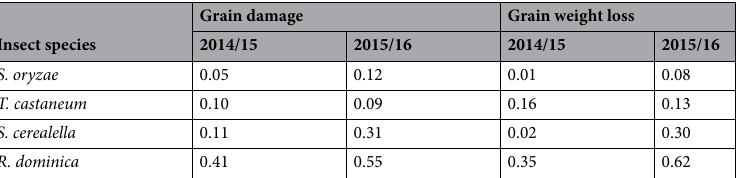
Table 7. Correlations between the number of live insects per species and percentage sorghum grain damage and weight loss during the 2014/15 and 2015/16 storage seasons (n = 280).